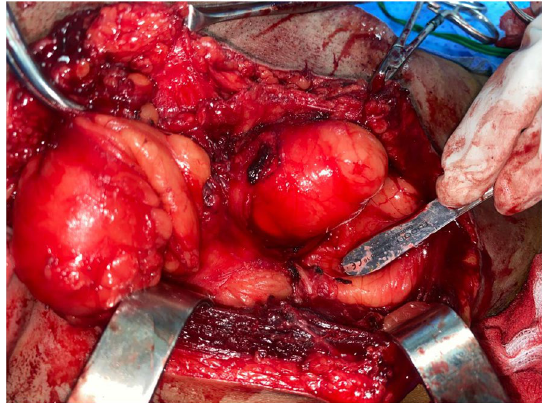
Fig. 4 Photo showing the appearance, volume (giant), location, and extension of the lipoma